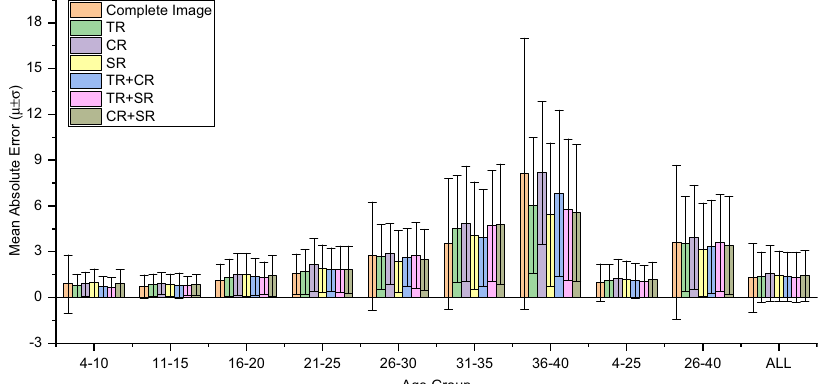
Fig. 2 The performance comparison of age estimation in each age group. The performances were obtained by using complete LCR images, the LCR images in which one ARDA concentrated region is selected, and the LCR images in which one ARDA concentrated region is discarded as the input of the baseline model (TR teeth region, CR craniofacial region, SR cervical spine region, μ mean of absolute error, and σ standard deviation of the absolute error). The heights of the bars indicate the values of the μ . The upper and lower endpoints of error bar in each bar indicate the values of μ + σ and μ − σ , respectively. Overall, the accuracy of age estimation with complete LCR images is better than the accuracy of any of the three regions being selected or discarded. Source data are provided as a Source Data fi